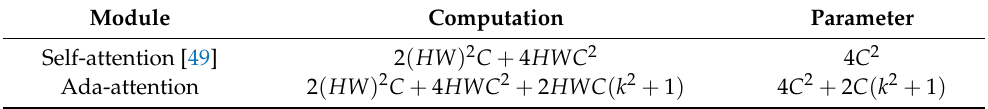
Table 1. Comparison computation and parameter between self-attention and Ada-attention. Module Self-attention